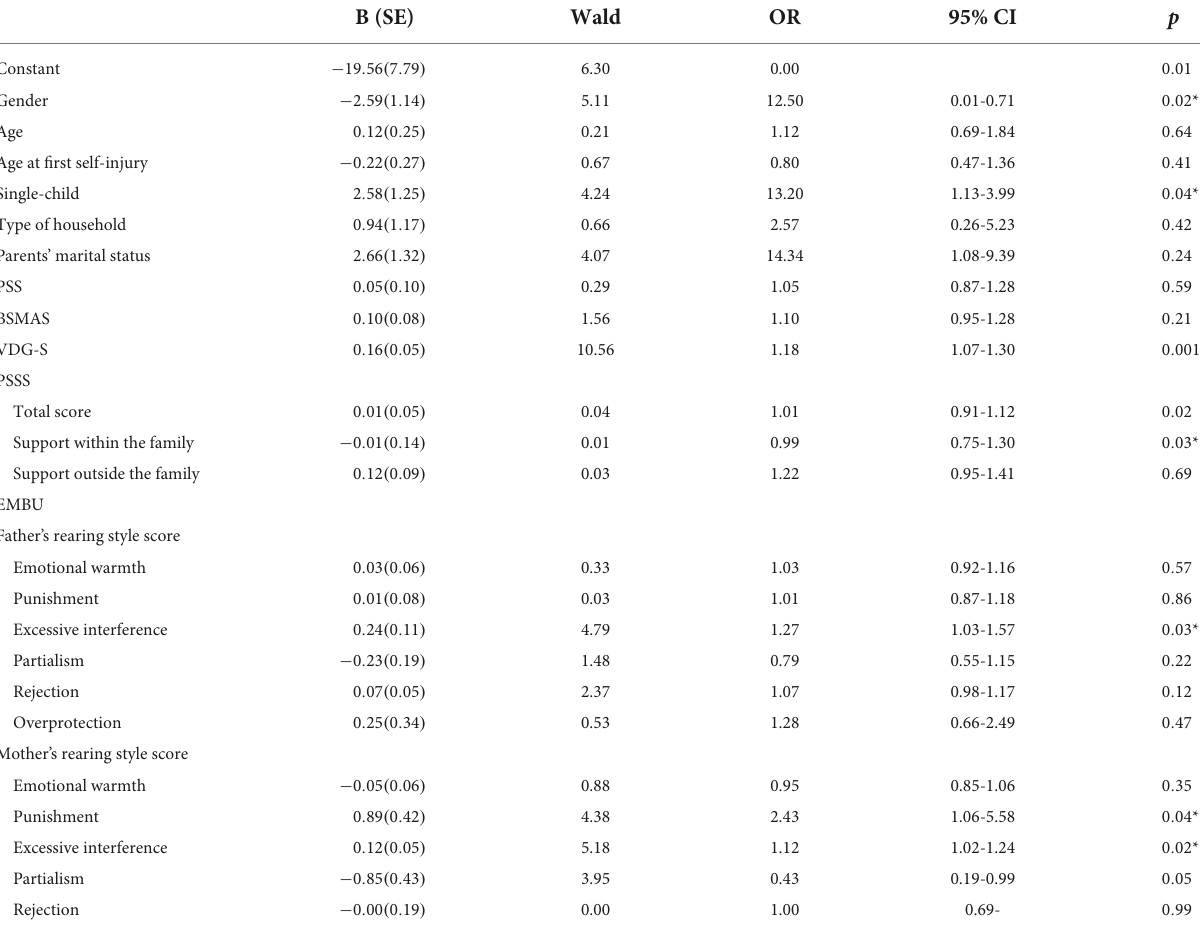
TABLE 4 The factors of addiction characteristics of NSSI behavior: Logistic regression